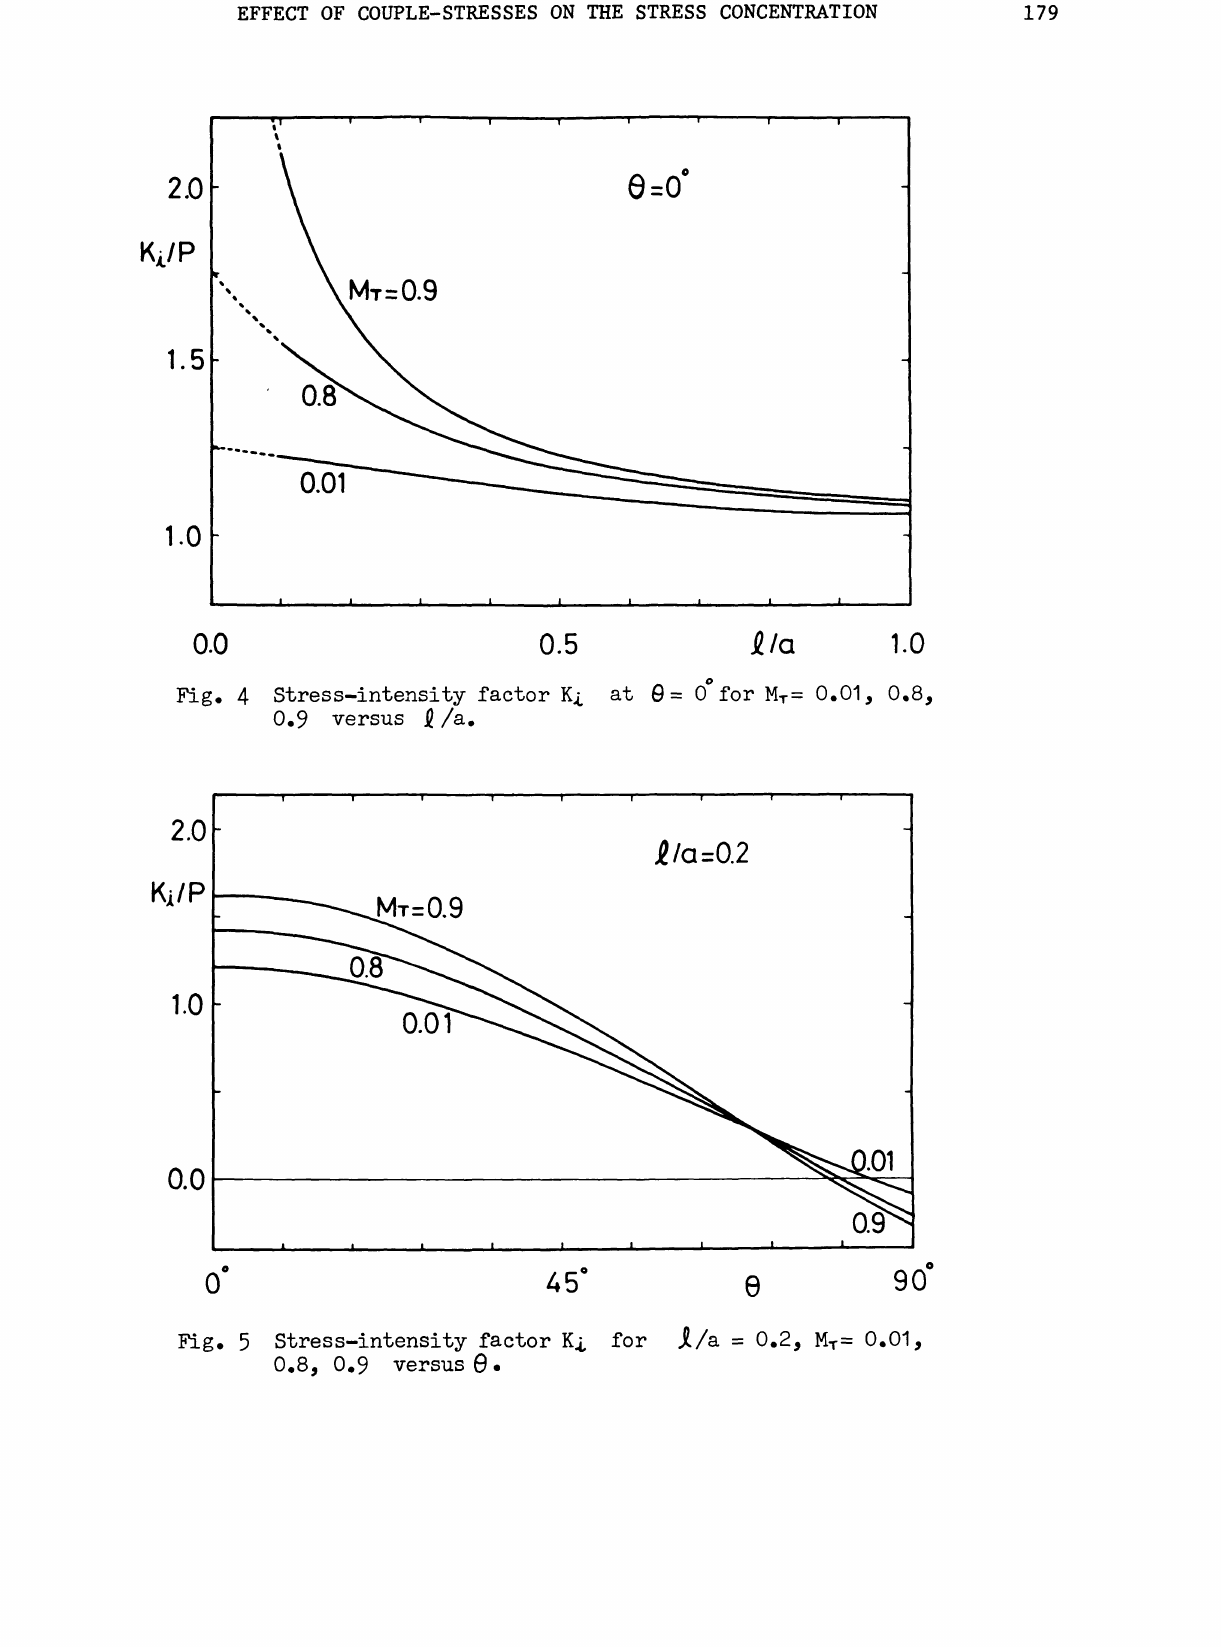
Fig. 5 Stress-intensity factor K 0.8, 0.9 versus